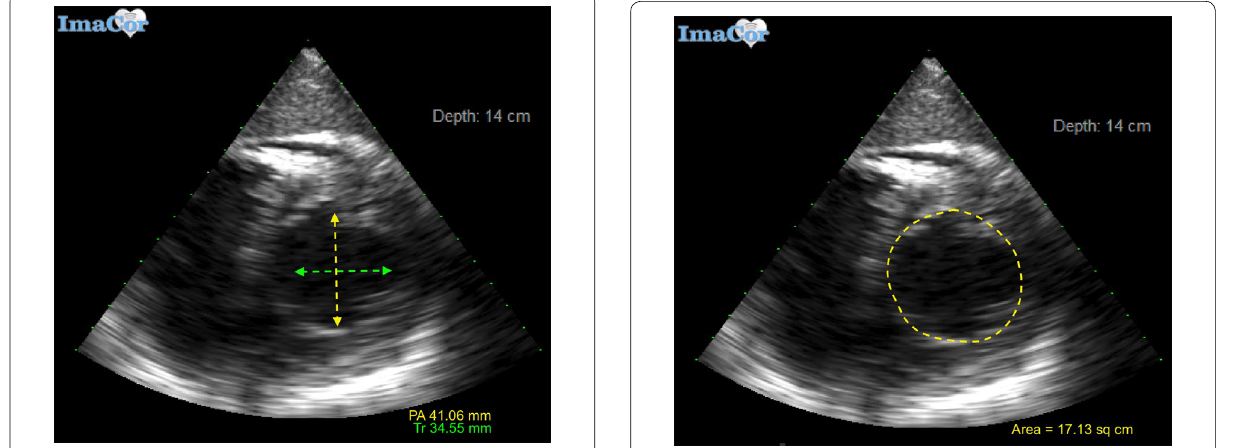
Fig. 3 Transesophageal echocardiographic view demonstrating area tracing of left ventricle in